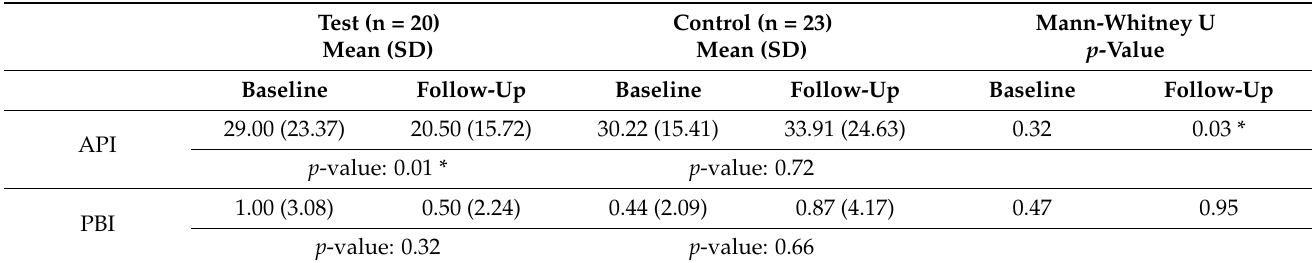
Table 7. API and PBI indices at baseline and